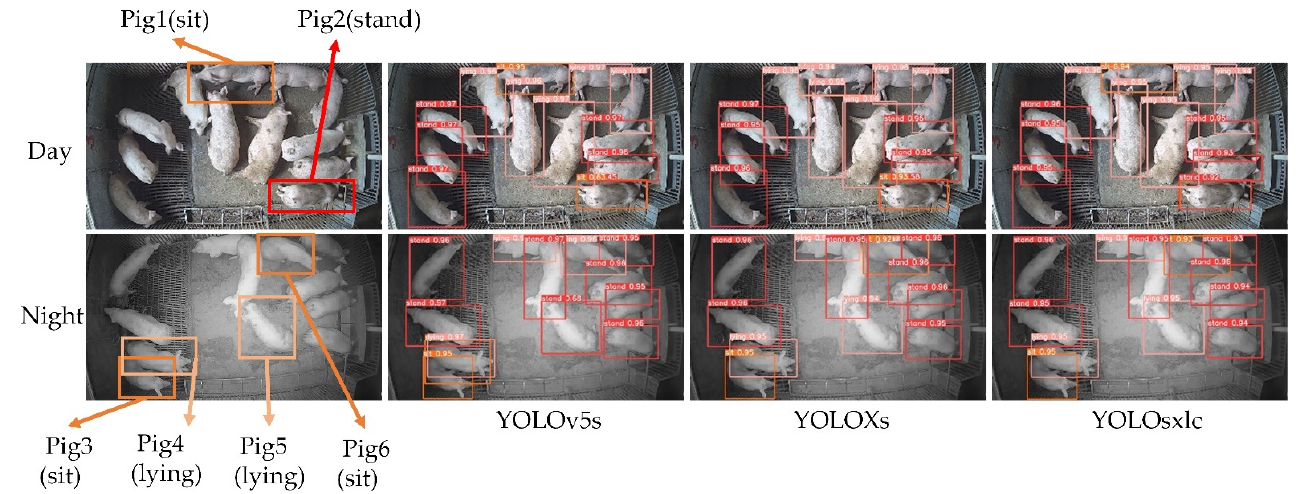
Figure 7. Comparison results of position detection and posture recognition between YOLOv5s, YOLOXs, and YOLOsxlc during daytime and nighttime.